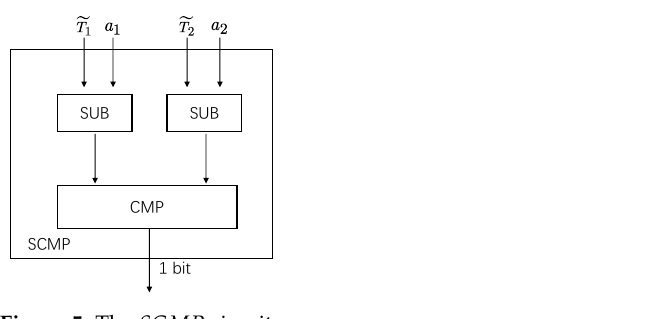
Figure 4. The time-comparing circuit TC .